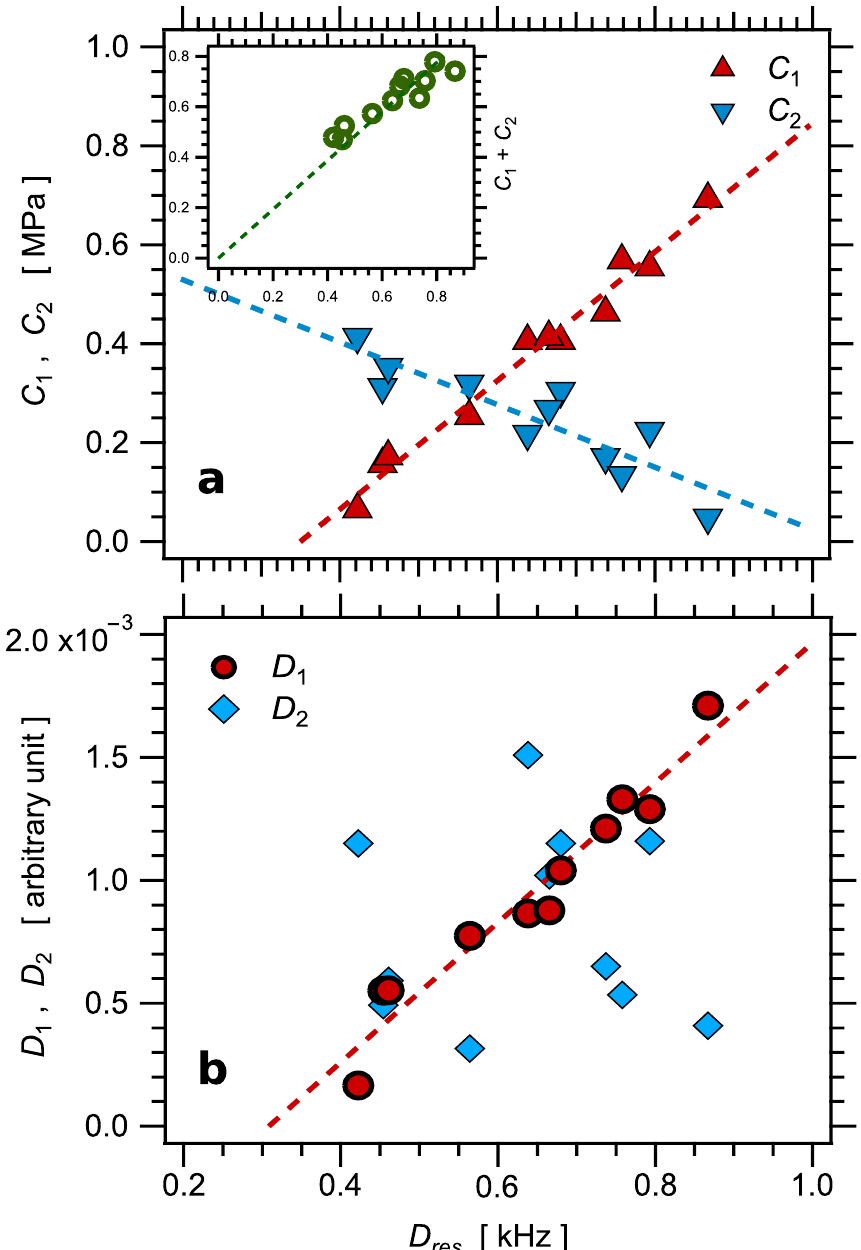
Figure 11. ( a ) TheMooney–Rivlin coefficients C 1 and C 2 fitted on the tensile stress–strain curves shown in Figure 10 as a function of D res . Inset: the zero strain modulus C 1 + C 2 as a function of D res . ( b ) The effective Mooney–Rivlin coefficients D 1 and D 2 fitted on the (cid:104) P 2 (cid:105) curves shown in Figure 13a. Dashed lines are linear fits of corresponding data and should be considered as guides for the